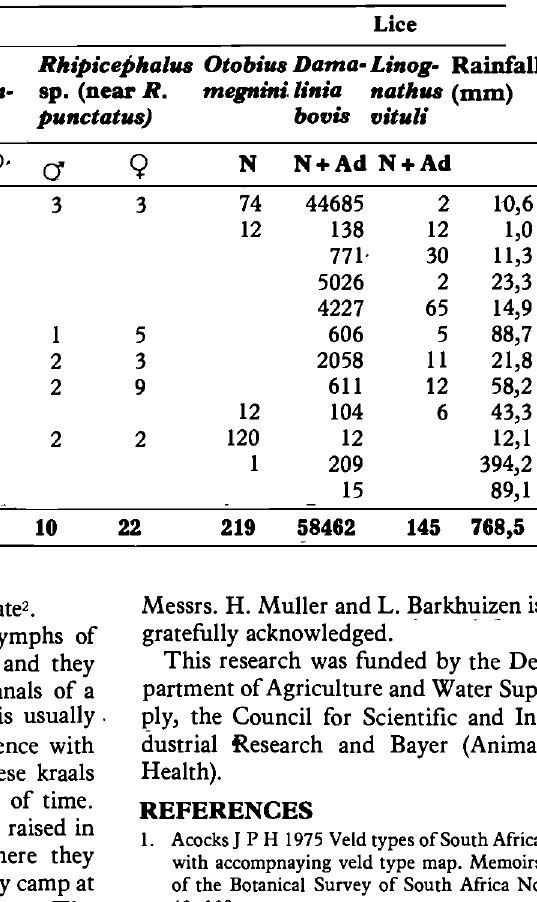
Table.: Ectoparasites recovered from 12 Friesian cattle on the farm "Preezfontein" in the south western Orange -Free